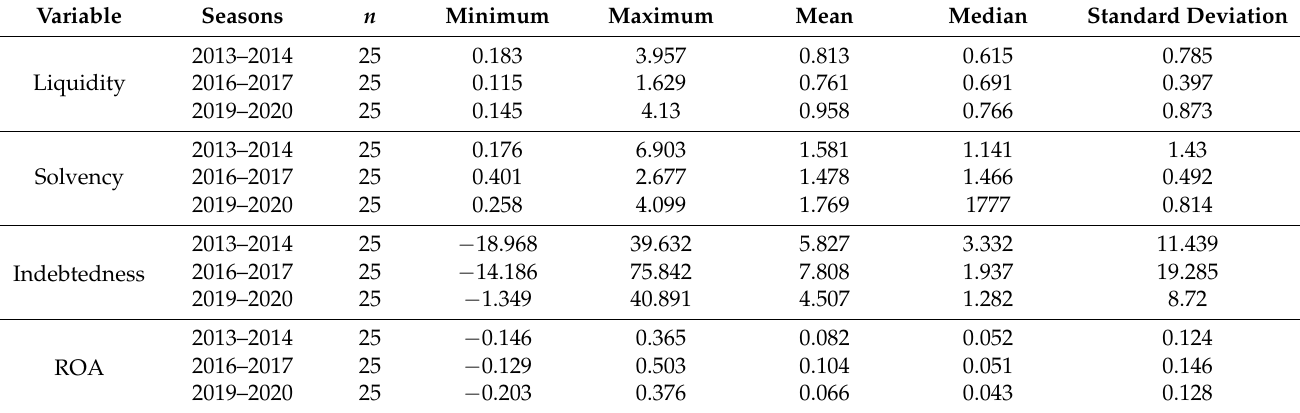
Table 2. Descriptive statistics of main financial